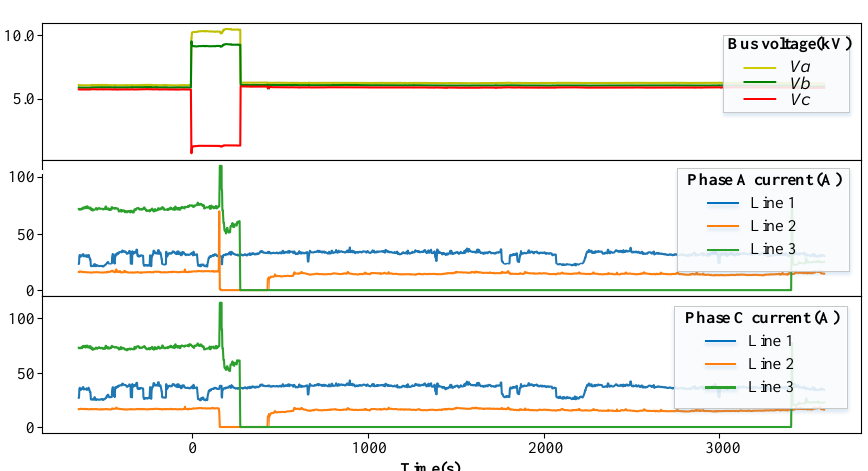
Table 3. Output of the FLS model for Figure 12.